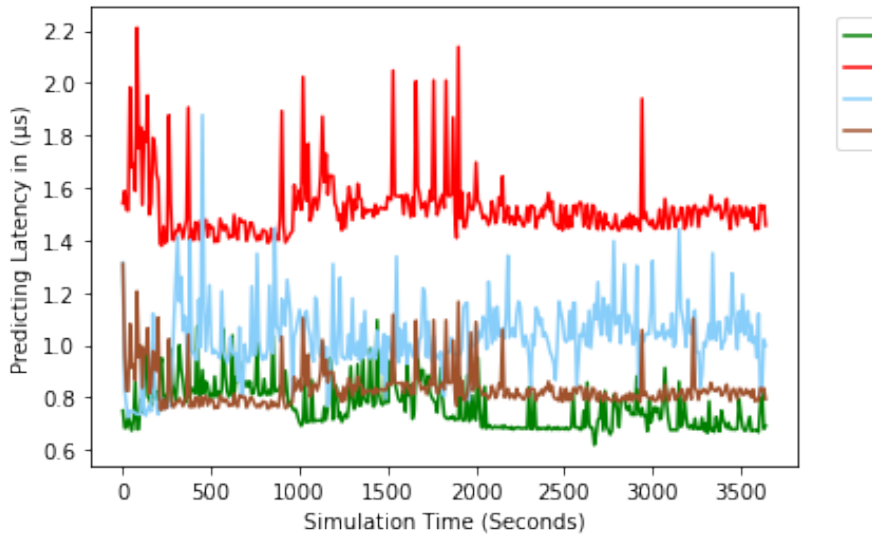
Figure 12. Comparison of NTPA predicting